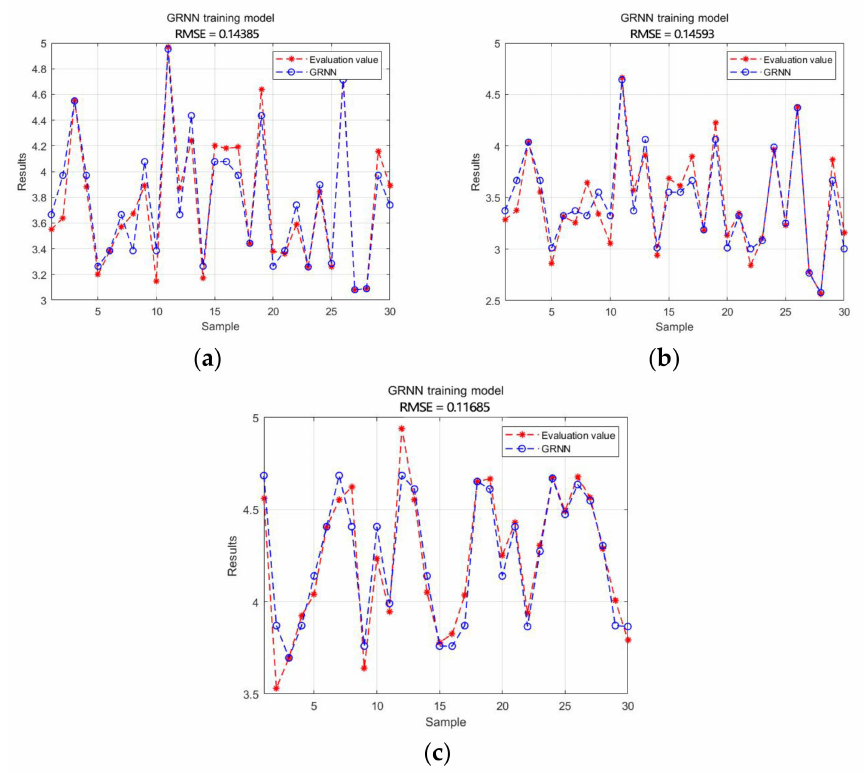
Figure 9. GRNN model of ( a ) “Annoyance-Comfortable”, ( b ) “Inexpensive-Premium”, and ( c ) “Weak- Powerful”.